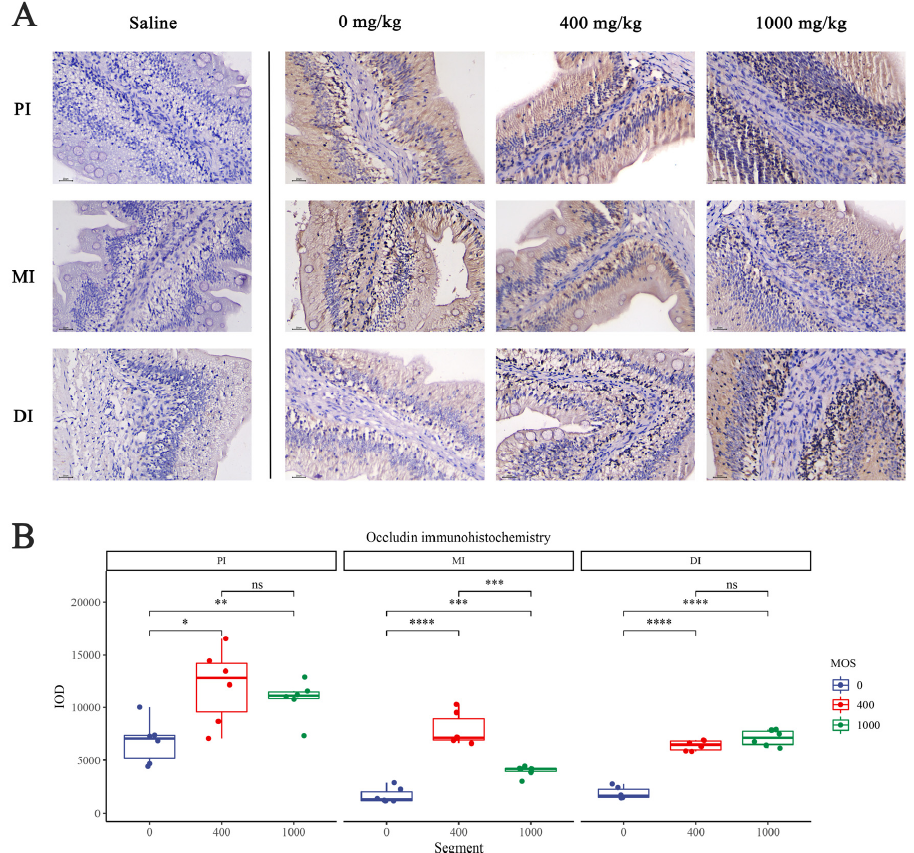
Figure 2. The effect of MOS on Occludin expression with the immunohistochemistry method in three intestinal segments after infection with Aeromonas hydrophila . ( A ) Occludin protein expression in the intestine in the 0 mg/kg MOS, 400 mg/kg MOS and 1000 mg/kg MOS groups; ( B ) Quantification of the positive area as revealed by Image Pro Plus 6.0. N = 6 for each MOS level. Differences among the variables were assessed using Student’s t -tests. Statistical significance: * p < 0.05; ** p < 0.01, *** p < 0.001; **** p < 0.0001; ns: not